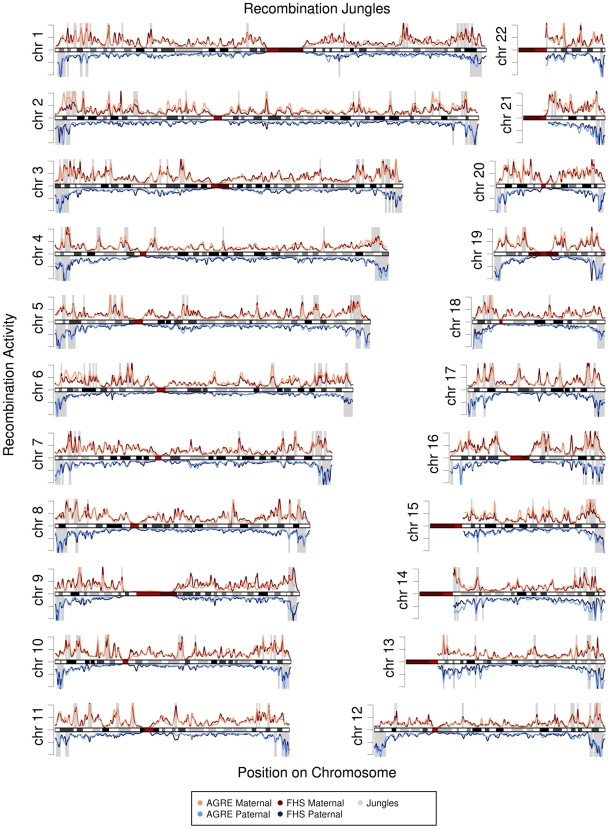
Recombination jungles across the human genome.The curves in each graph represent the intensity of recombination activity across the chromosome. Regions with the most recombination activity (2 standard deviations above the mean) are shaded in gray and are considered “recombination jungles.” Recombination events for females (top) and males (bottom) are shown for the AGRE (pink and light blue) and FHS (red and dark blue) samples. Chromosome ideograms show centromeres in red and patterns of Giemsa staining in different shades of grey.